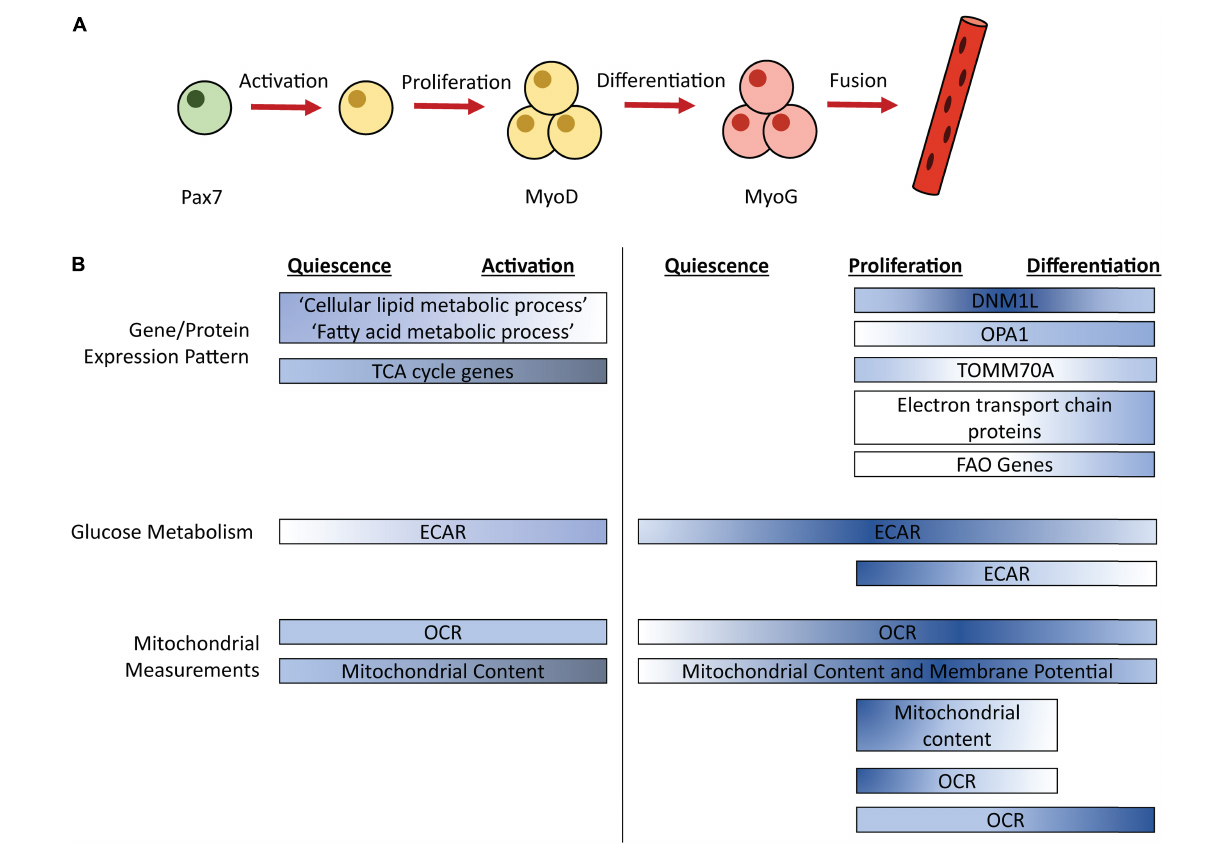
Frontiers in Physiology |